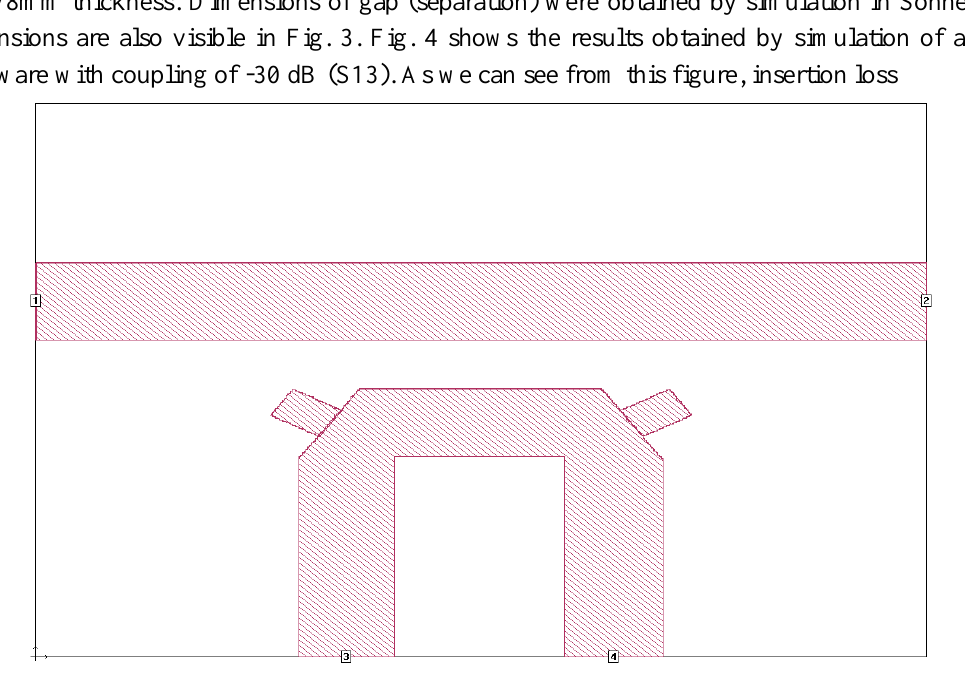
Figure 5. Schematic of the microstrip coupler with compensating